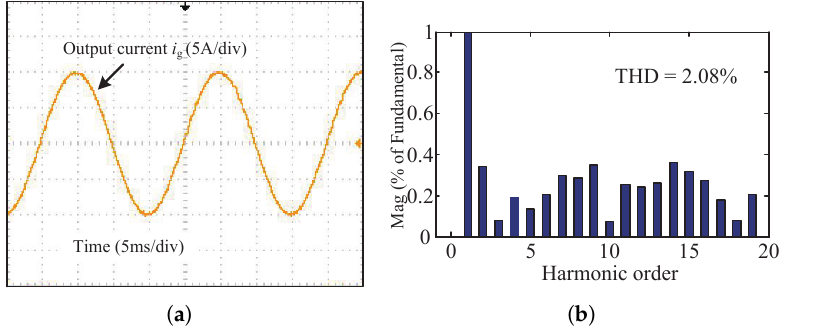
Figure 13. FO-PIMR-RC ( m = 3.7) control system with k r = 9: ( a ) The output current waveform; ( b ) The output current spectrum